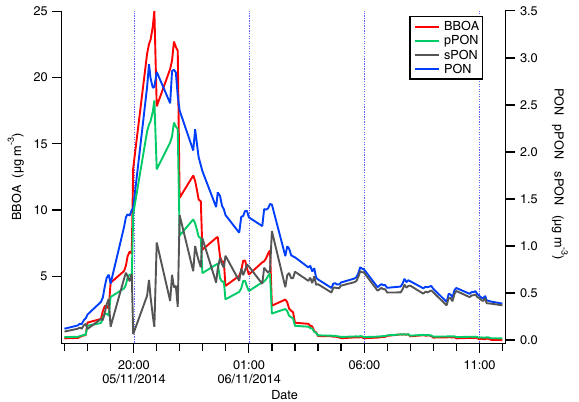
Figure 6. Secondary (sPON) and primary (pPON) organic nitrate time series estimated from PON and BBOA.